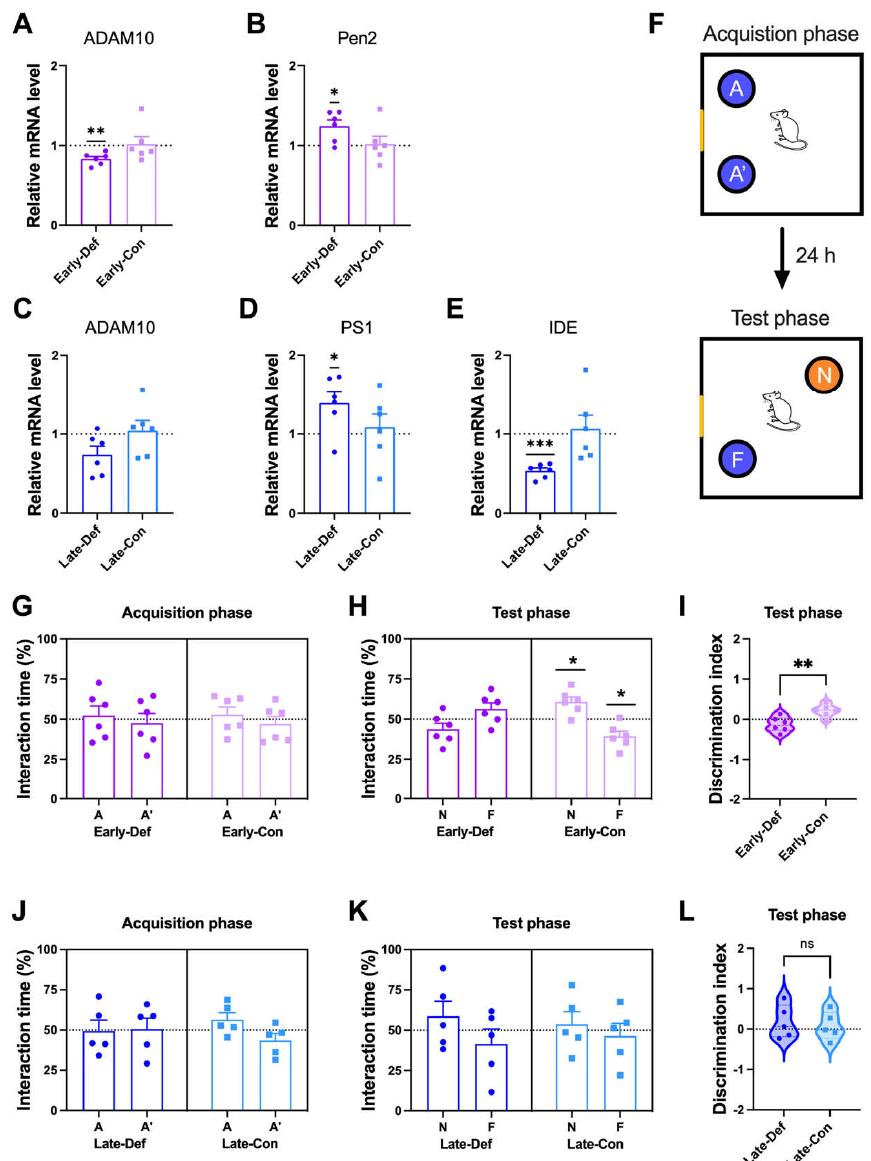
Figure 2. Vitamin D deficiency induced more Aβ processing and memory impairment in AD model mice. ( A , B ) Results of a quantitative real-time polymerase chain reaction (qRT-PCR) analysis of RNA for the key factors of Aβ processing of ( A ) ADAM10 and ( B ) Pen2 in the Early-Def ( n = 6) and Early-Con ( n = 6) groups are shown. ( C – E ) The qRT-PCR analysis results of ( C ) ADAM10, ( D ) PS1, and ( E ) IDE of the Late-Def ( n = 6) and Late-Con ( n = 6) groups are shown. ( F ) Schematic diagram of the novel place recognition (NPR) task. A and A’ denote identical objects. F and N indicate familiar and novel locations. A Yellow fragment in the rectangular outline represents a mark on the wall as a visuospatial cue. ( G ) Object interaction time of the Early-Def and Early-Con groups during the acquisition trial. ( H ) Interaction time in a novel location and familiar location of the Early-Def and Early-Con groups. ( I ) The discrimination index implies the relative preference for the novel location. The interaction times of the Late-Def and Late-Con groups in ( J ) the acquisition and ( K ) test phases are illustrated. ( L ) The discrimination index of mice in the Late-Def and Late-Con groups is shown. Dots represent individual mice data in each group. The interaction times for each location are expressed as a percentage of the total exploration time and as the statistical difference against a 50% theoretical mean (one-sample t -test). The data are presented by the mean ± SEM of each group. * p < 0.05, ** p < 0.01, and *** p < 0.001 by the Student’s t